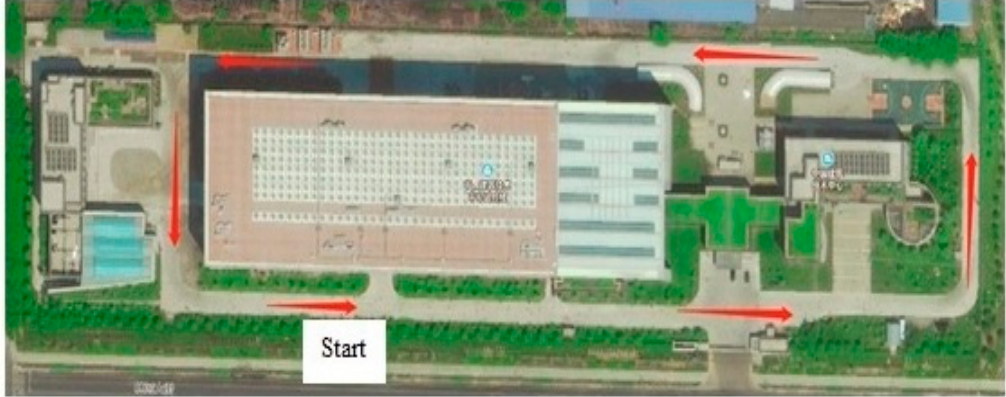
Figure 16. An aerial photograph of the construction site. Sensors 2019 , 19 , x FOR PEER REVIEW